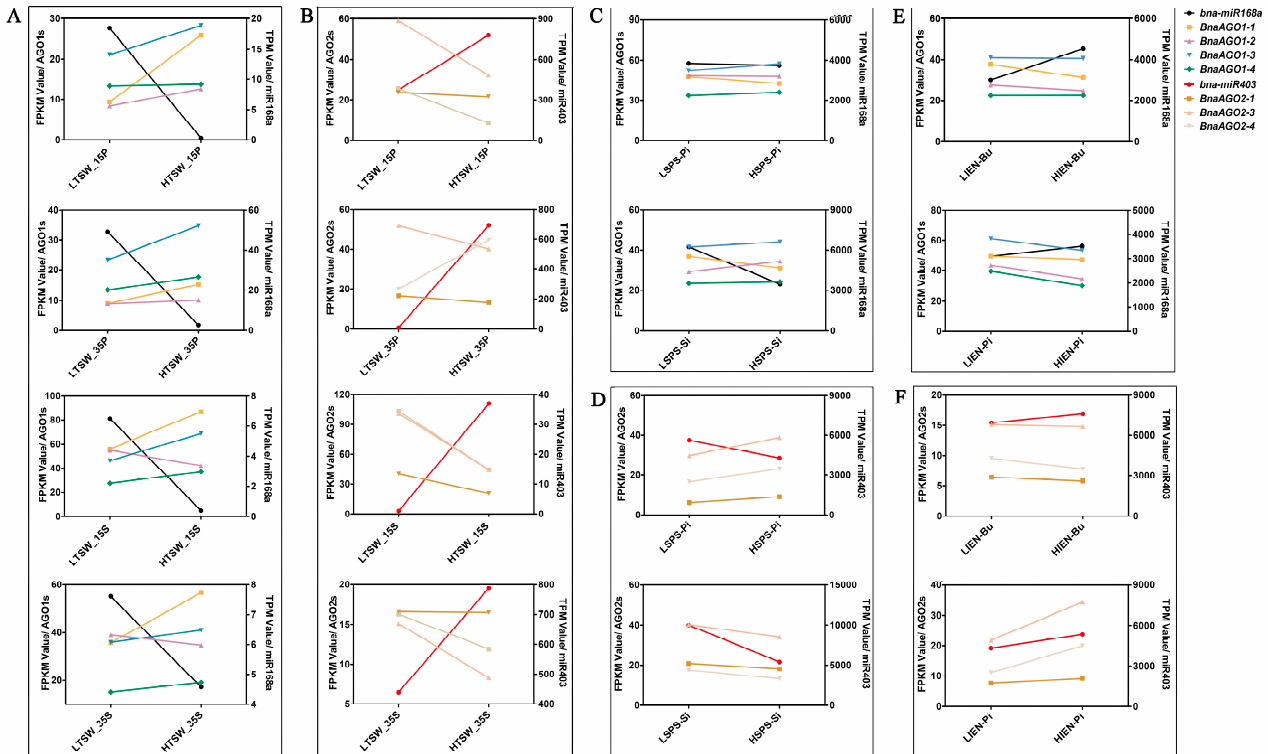
Figure 7. The joint analysis between miRNA-Seq and mRNA-Seq of B. napus miR168-AGO1s and miR403-AGO2s in yield-related materials with differences in thousand-seed weight (TSW); ( A , B ), seed number per silique (SPS); ( C , D ), and initial embryonic number (IEN); ( E , F ). LTSW and HTSW indicate high- and low-TSW materials; LSPS and HSPS indicate high- and low-SPS materials; LIEN and HIEN indicate high- and low-IEN materials; FPKM: Fragments Per Kilobase of exon model per Million mapped fragments; TPM: Transcripts Per Kilobase of exon model per Million mapped reads; The numbers used in the labels on the x -axis (15 and 35) indicate the day after flowering; P: pericarp; S: seed; Pi: pistil; Si: silique; Bu: bud. All FPKM and TPM data were shown in Supplement Table S3 and Table S4, respectively.